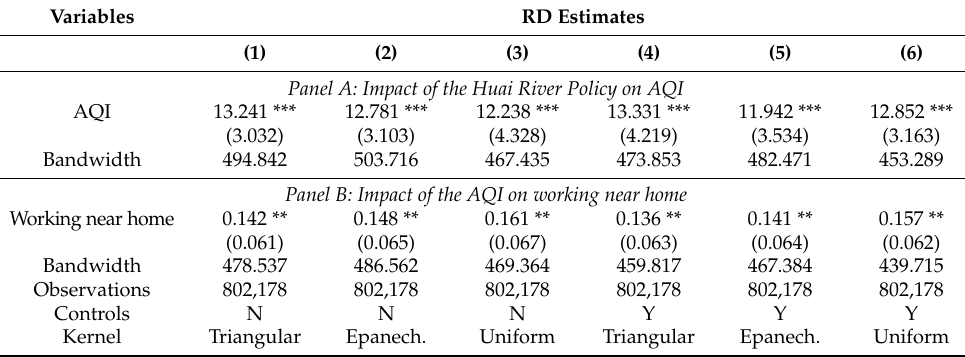
Table A2. Robustness to using the alternative air pollution measure (AQI).